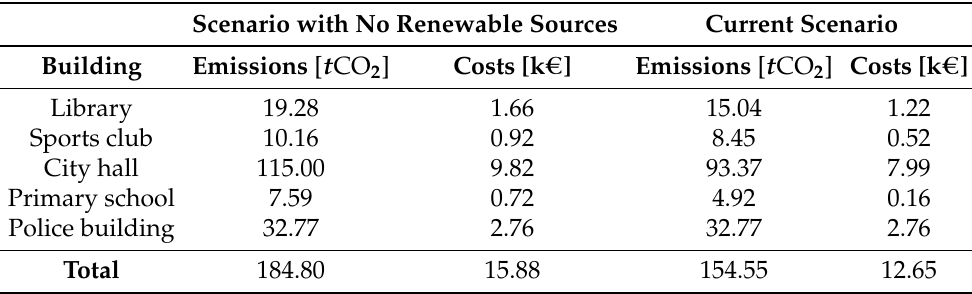
Table 2. Comparison of economic and environmental Key Performance Indexes (KPIs) between the current and the absence of installed renewable sources